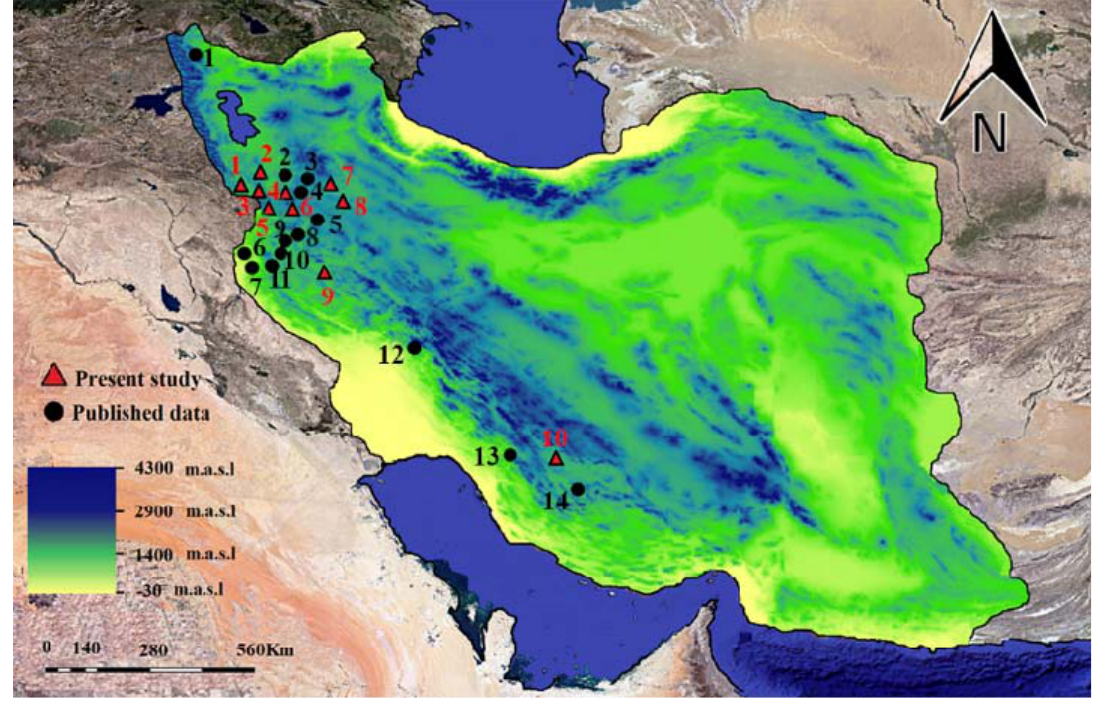
F IGURE 1. Geographical distribution of the Rhinolophus mehelyi in Iran. Records from this study (triangles) are summarized in Appendix 1, and published localities (circles) are in Appendix